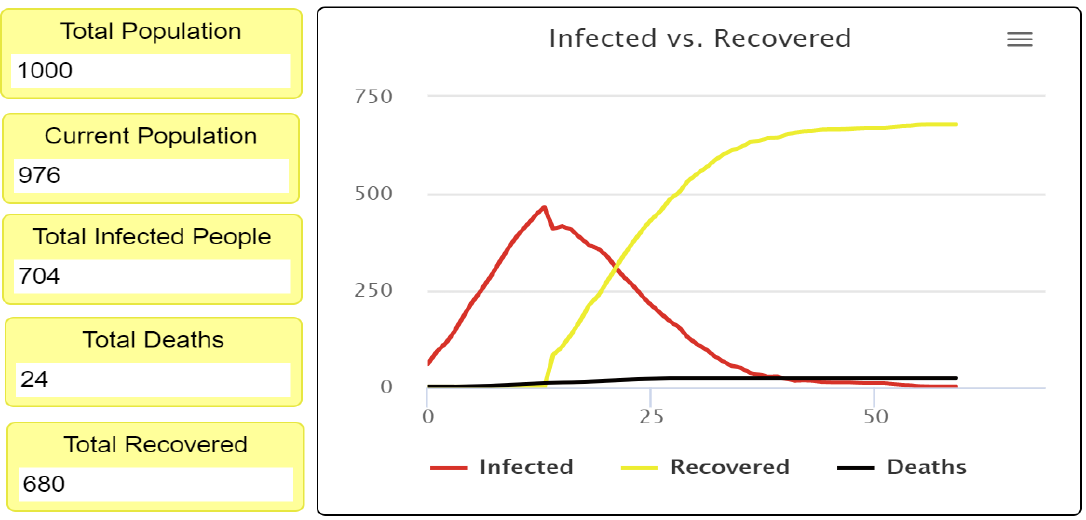
Figure 13. Infected versus the recovered people curve, when the fatality rate is 3% with 30% social distancing.